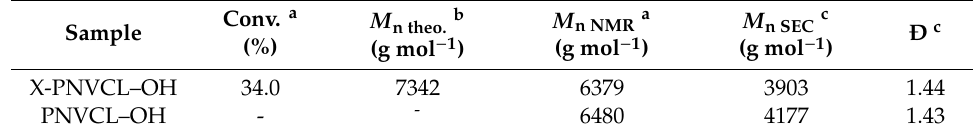
Figure 1. Size exclusion chromatography (SEC) chromatogram of PNVCL homopolymer before ( a, X–PNVCL–OH) and after ( b, PNVCL–OH) chain end removal by reaction with 2,2 ′ -azobis (isobutyronitrile) (AIBN). Table1. Related data on PNVCL–OH homopolymer obtained by NVCL Reversible Addition-Fragmentation Chain Transfer (RAFT) / macromolecular design by the interchange of xanthates (MADIX)